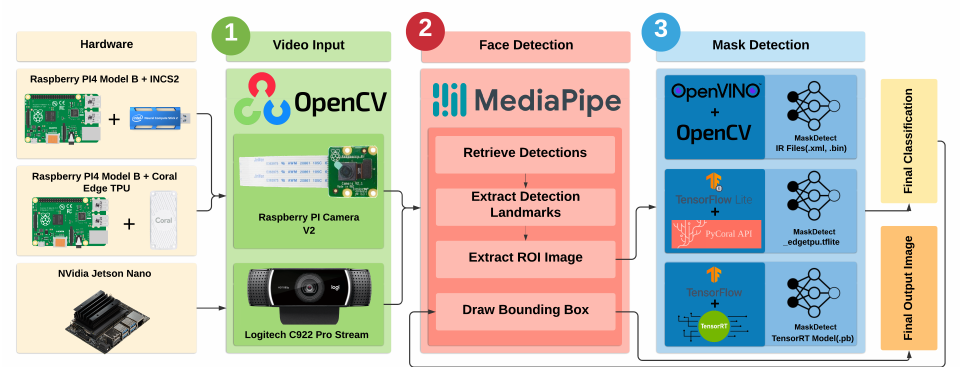
Figure 1. Overview of the proposed face-mask detection system that considers the combination of NVIDIA Jetson Nano 2 GB, Coral Edge TPU, Raspberry Pi4 Model B 8 GB, and INCS2 for three different hardware implementations. Video input module provides live video stream to the face-detection subsystem (FDS). FDS extracts facial regions from the input and sends them to the mask-detection subsystem (MDS). MDS uses proposed optimised hardware-specific MaskDetect to classify inputs. Classification is sent back to FDS, which then uses it to create a labeled bounding box onto the final output feed.